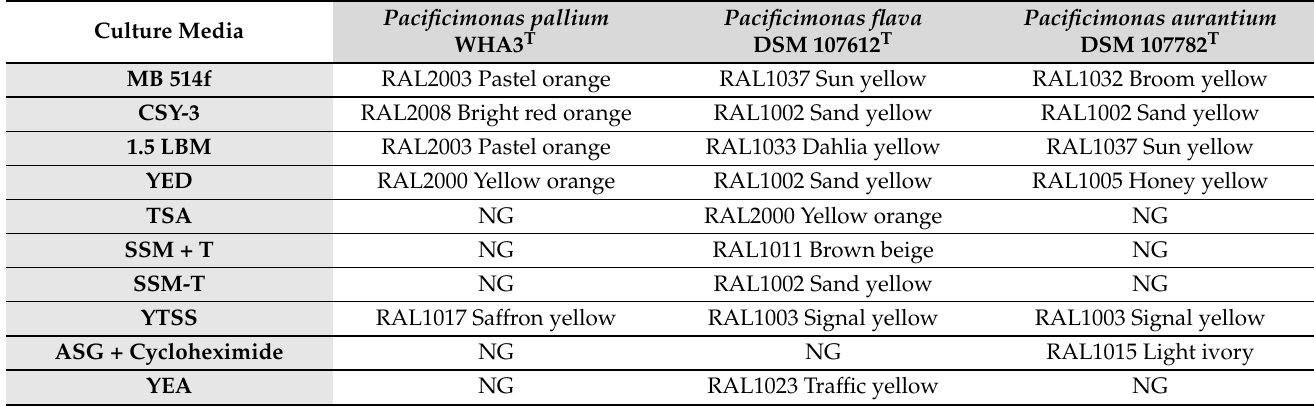
Table 1. Colony color comparison of the three strains, WHA3 T , Pacificimonas flava DSM 107612 T , and